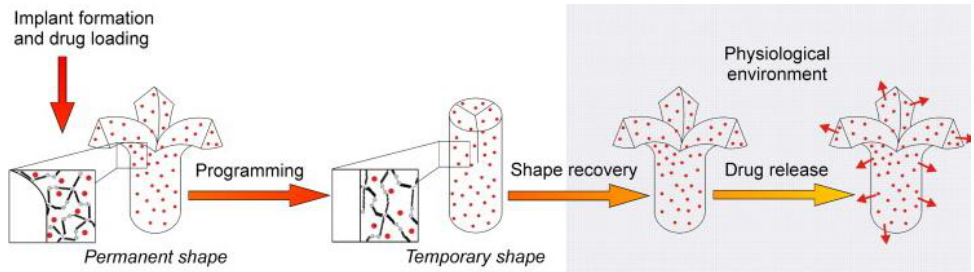
Figure 5. Programming of shape-recovery of polyester urethane shape memory polymer network in physiologic medium and temperature, and controlled drug release. Reprinted with permission from [84].